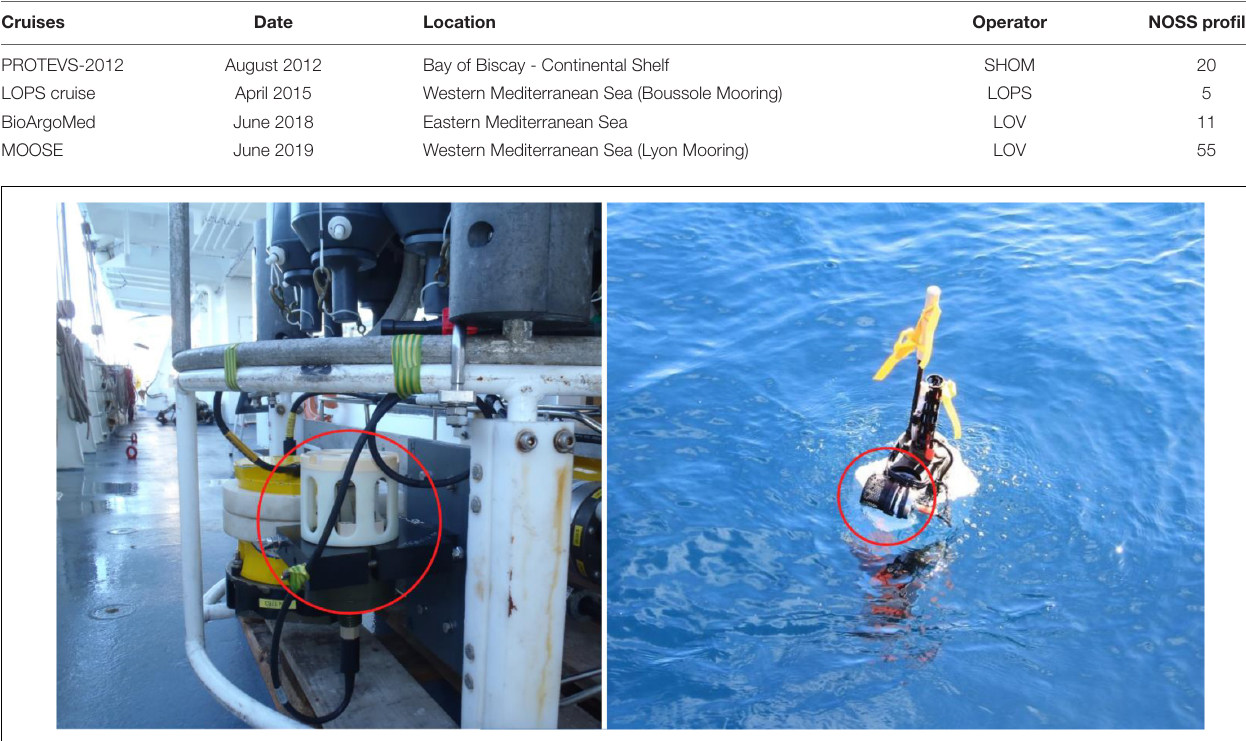
FIGURE 8 | Left : NOSS Absolute Salinity sensor mounted on a cage during the PROTEVS oceanographic campaign in 2012 (courtesy of SHOM). Right : NOSS on a Provor float in 2015 (courtesy of LOV).